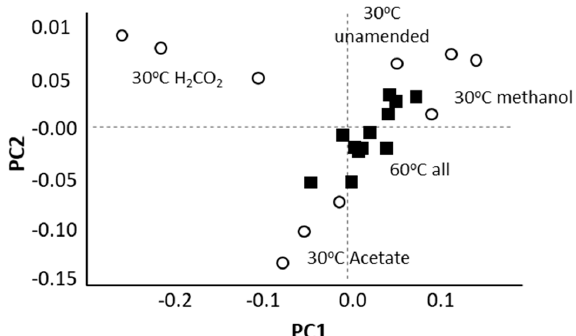
Figure 2. A Principal Component Analysis (PCA) based on an analysis of archaeal ASV (amplicon sequence variants) frequencies within 16S rRNA sequence libraries constructed from methanogenic enrichments indicates that archaeal communities were distinct based on substrate amendment at 30 ◦ C (white circles) but not at 60 ◦ C (black